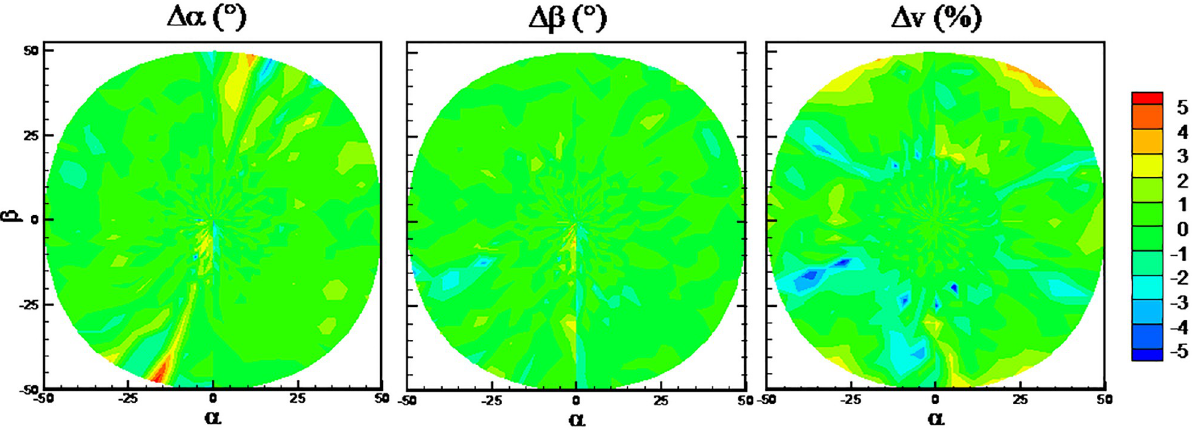
Fig 15. Error distributions with the traditional